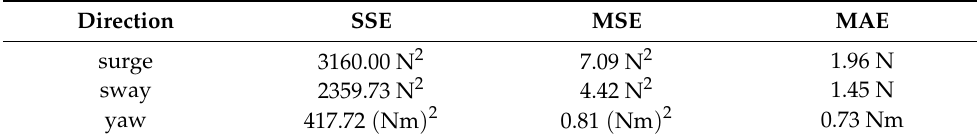
Table 2. Predicting error of the regression models.